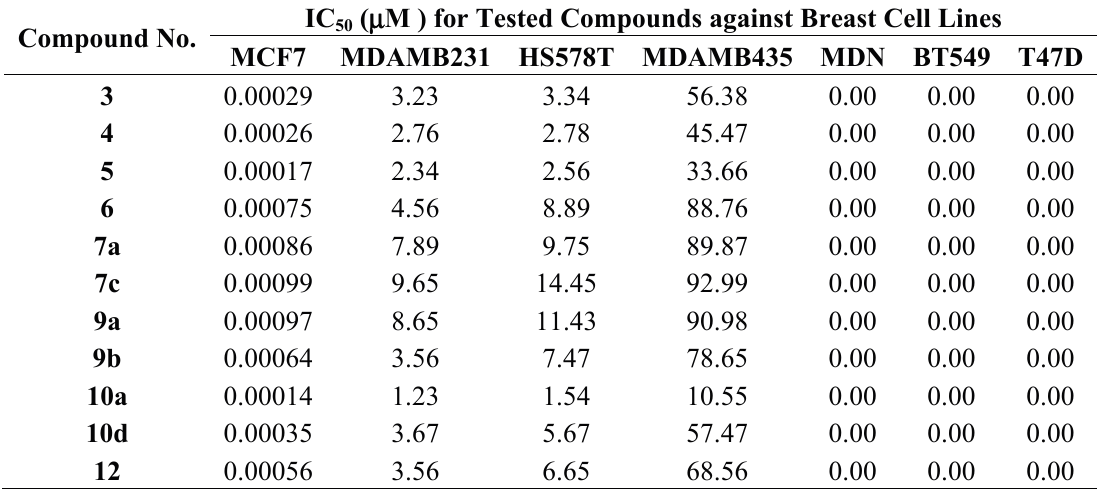
Table 3 . In vitro anti-tumor activity of the tested compounds was evaluated in different cell lines of breast cancer. Compound No.